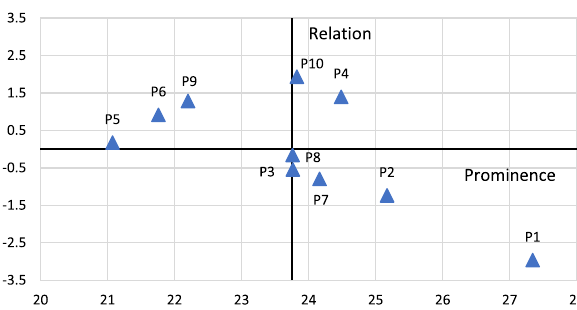
Fig. 1 The chart of interactive influence degree